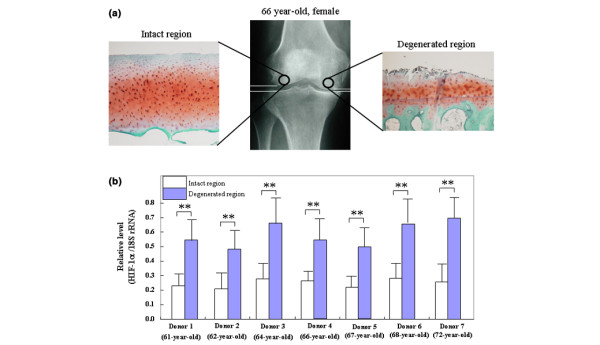
Levels of HIF-1α mRNA in the articular cartilage from patients with osteoarthritis (OA). (a)Representative x-ray film of knee joint and safranin-O staining for hypoxia-inducible factor 1α(HIF-1α) in the degenerated region and intact region of articular cartilage from a 66-year-old woman with OA. Original magnification of histological sections × 200. (b) The mRNA levels of HIF-1α were higher in the degenerated regions than in the intact regions from the same OA sample.